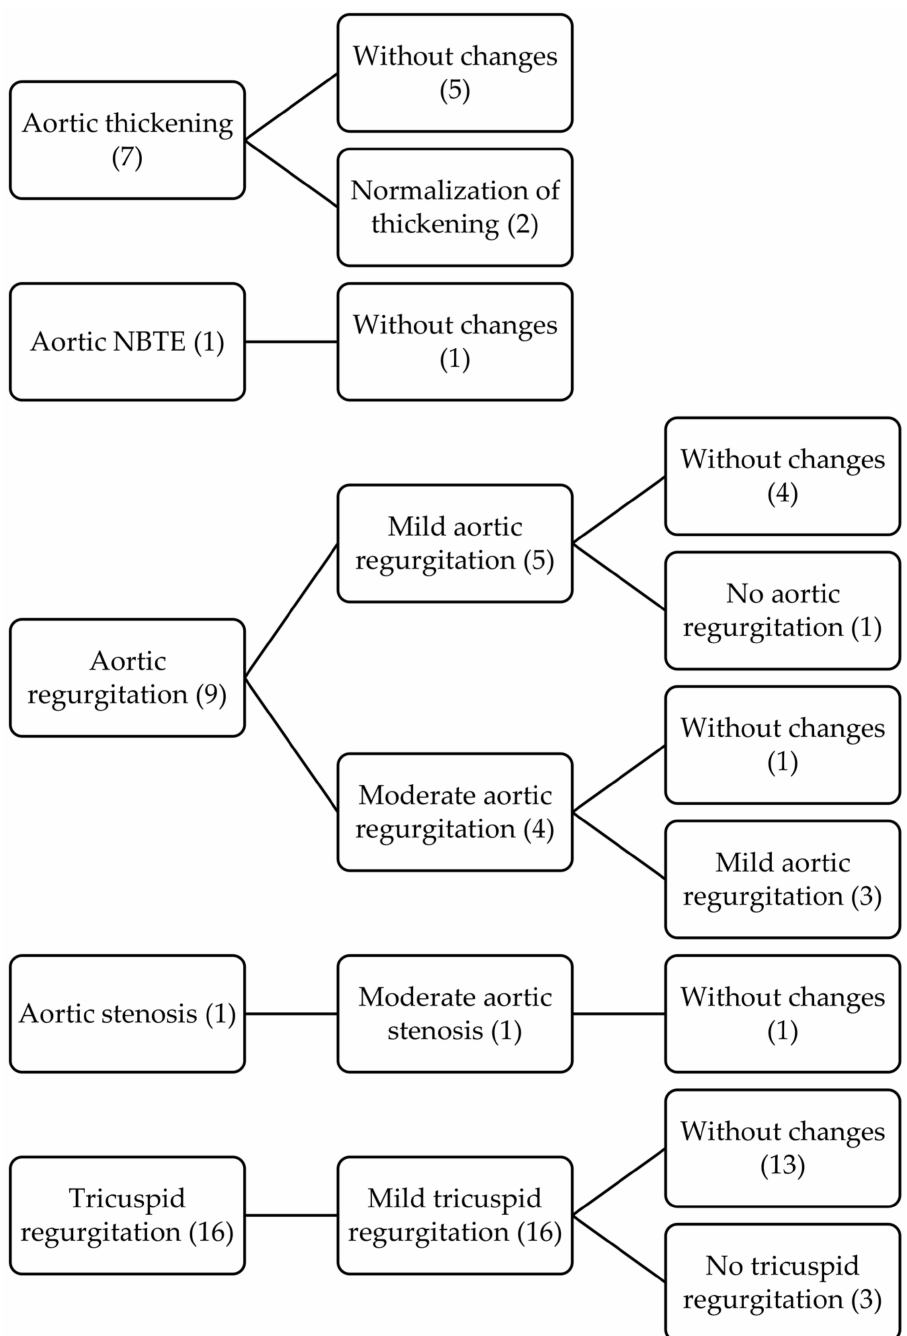
Figure 2. Timeline diagram with evolutive changes of aortic and tricuspid valve involvement. It is noteworthy that of the 11 patients with non-bacterial thrombotic endocarditis on the mitral valve, eight presented regressions of the lesion, disappearing completely in three of them. Of these 11 patients, 10 (91%) received anticoagulation, and only one (9%) was treated with aspirin, who remained with an unchanged thrombotic valve